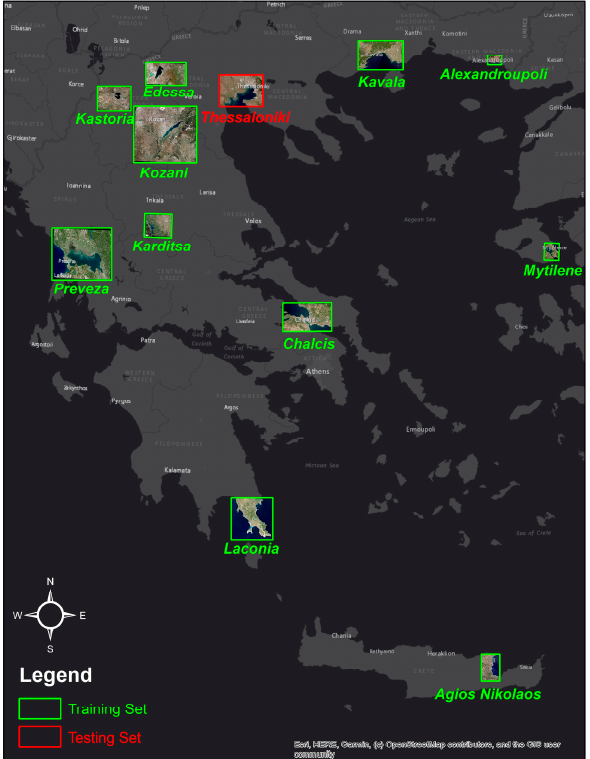
Figure 2. The selected training sites (green polygon) as well as the testing site (red